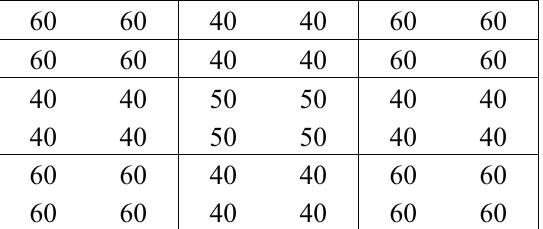
Table 4. Force map of arbitral distribution setting under 1.8 kg loading.